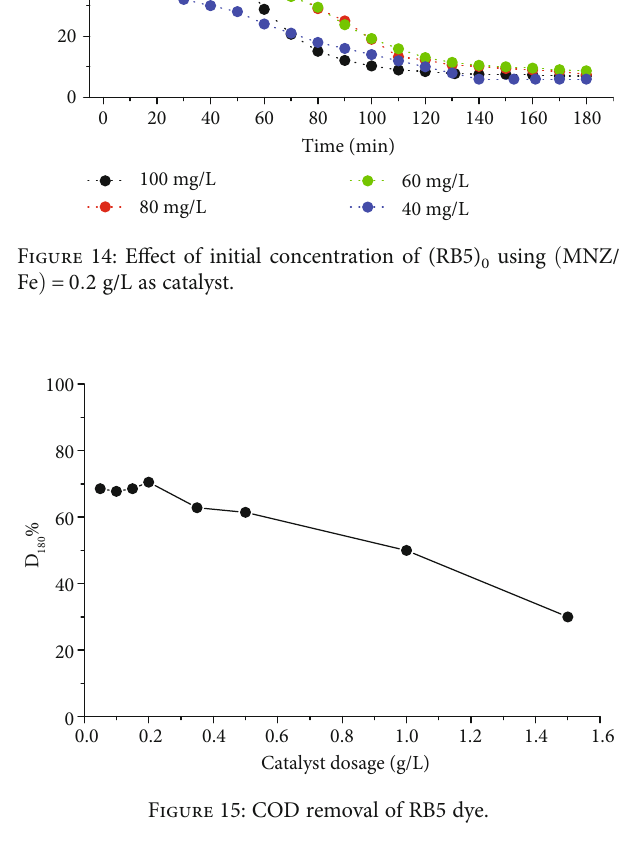
Figure 15: COD removal of RB5 dye.